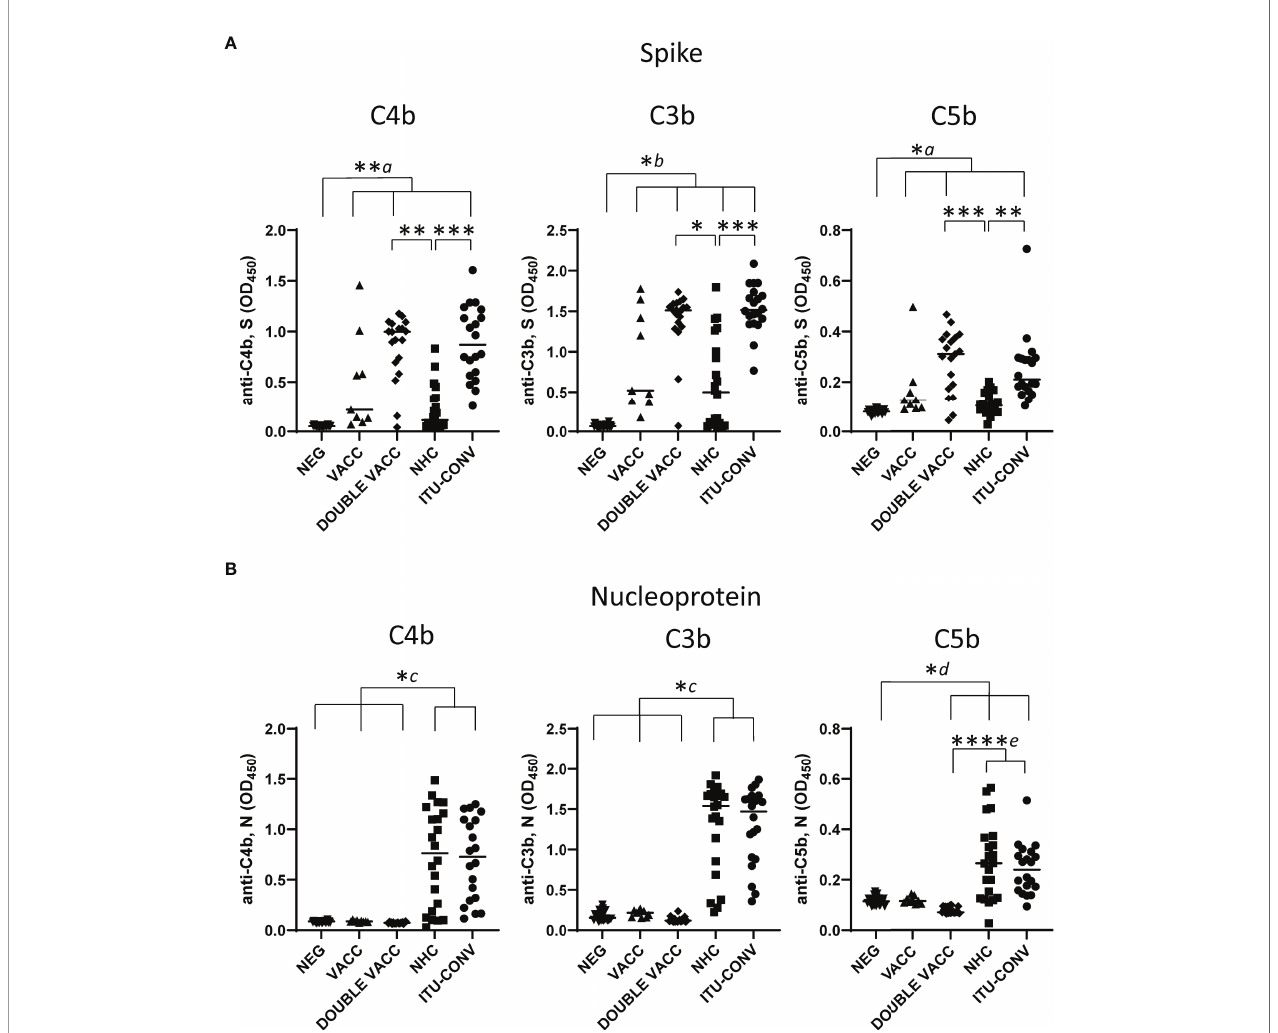
FIGURE 3 | C4b, C3b and C5b show antigen and subject status-dependent variability. Using an ELISA against 0.1ug S (A) or N (B) with either anti-C4b, C3b or C5b secondary antibody, followed by an HRP-conjugated tertiary, downstream complement binding was measured. NEG, n = 22. VACC, n = 9. DOUBLE VACC, n = 19. NHC, n = 22. ITU-CONV n = 20. Kruskal-Wallis with Dunn ’ s multiple comparisons test was used. a and b indicate that the groups bracketed were individually signi fi cantly different to the NEG group; c indicates that NHC and ITU-CONV are independently signi fi cantly different to NEG, VACC and DOUBLE VACC; d indicates that DOUBLE VACC, NHC and ITU-CONV are all signi fi cantly different to NEG; e indicates that NHC and ITU-CONV are both signi fi cantly different to DOUBLE VACC. ****p < 0.0001, ***p < 0.001, **p < 0.01, *p < 0.05. Bars represent median values for each